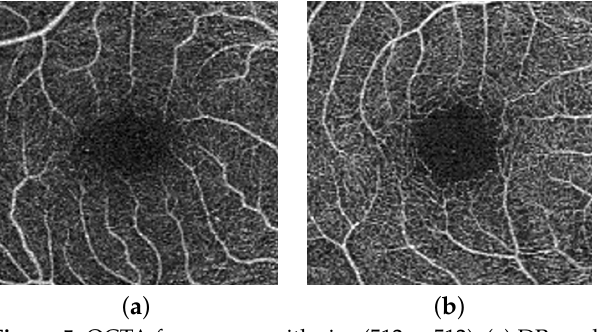
Figure 5. OCTA fovea zone with size (512 × 512); ( a ) DR, and ( b )